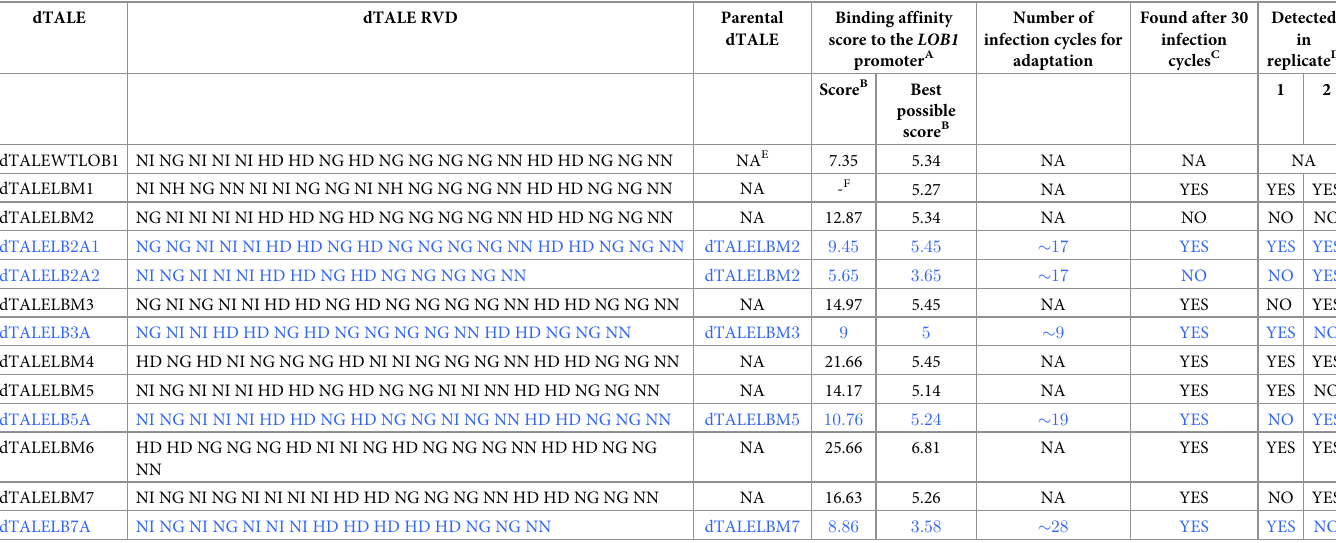
Note A The binding affinity analysis was conducted in LOB1 variant A from sweet orange ( Citrus × sinensis ). The promoter region was set as the 1,000 bp sequence upstream of the transcriptional start site. B